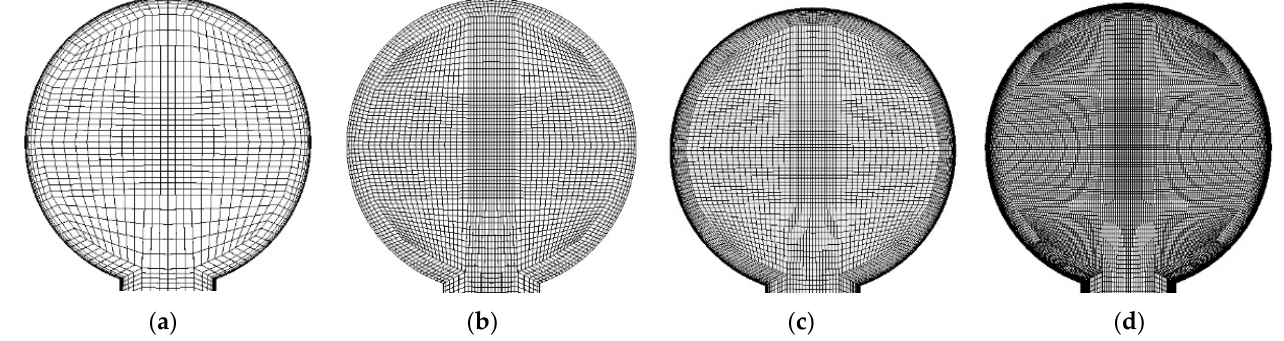
Table 2. Information for grid independence.